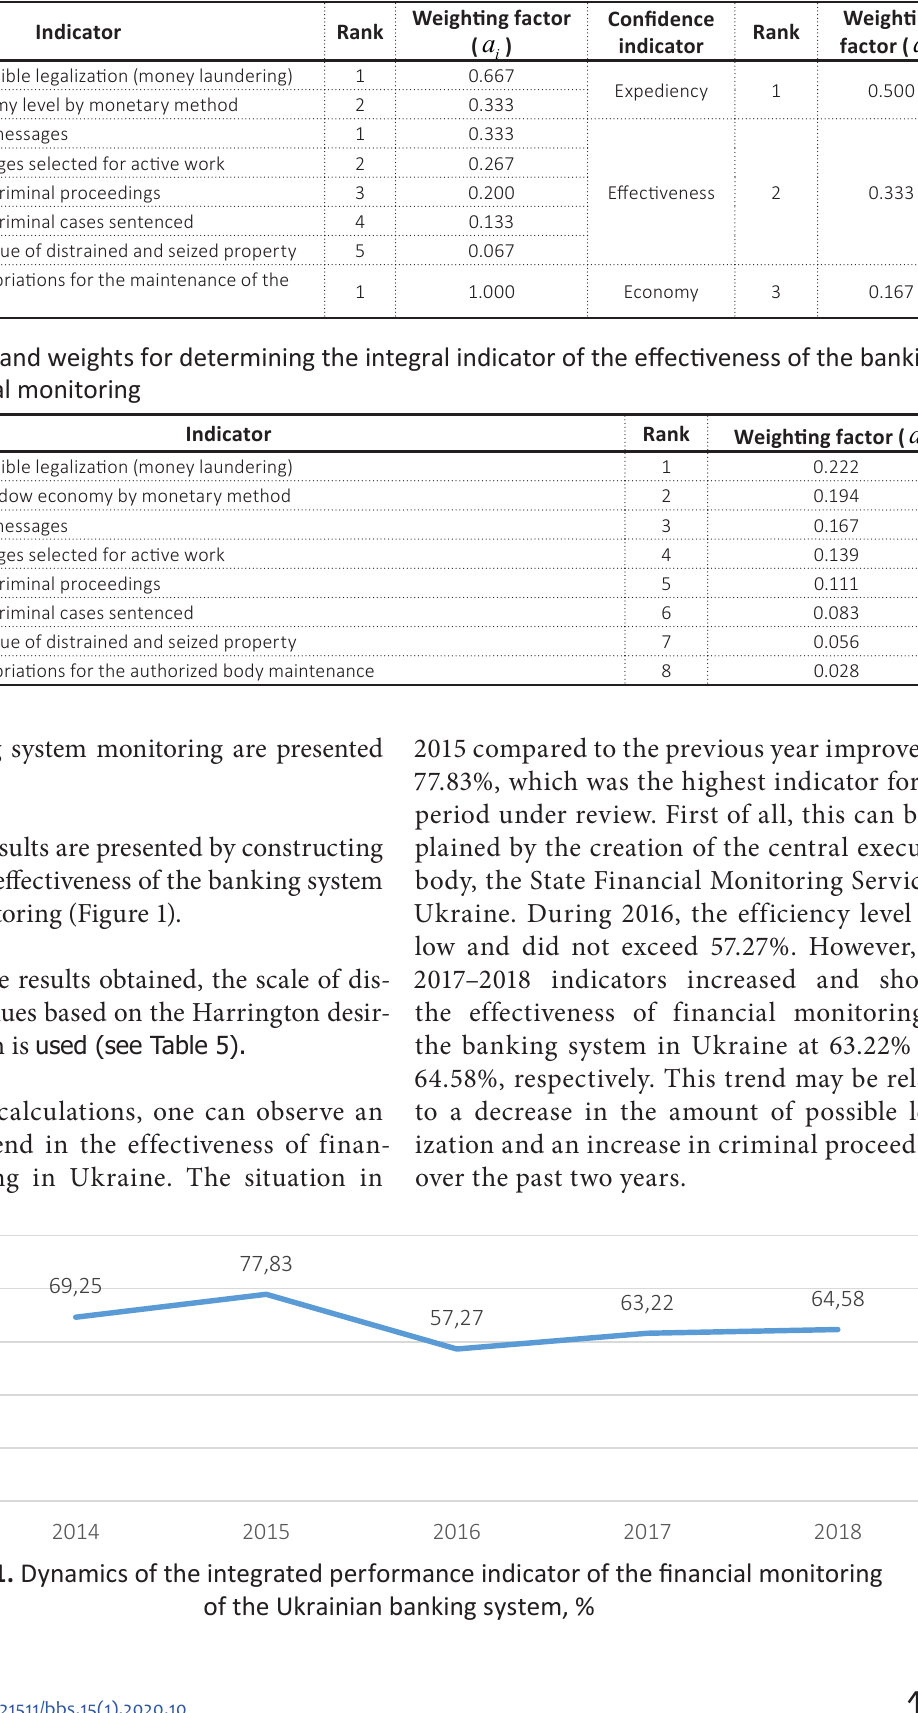
Table 3. Weighting coefficients for the aggregate financial monitoring performance of the Ukrainian banking system